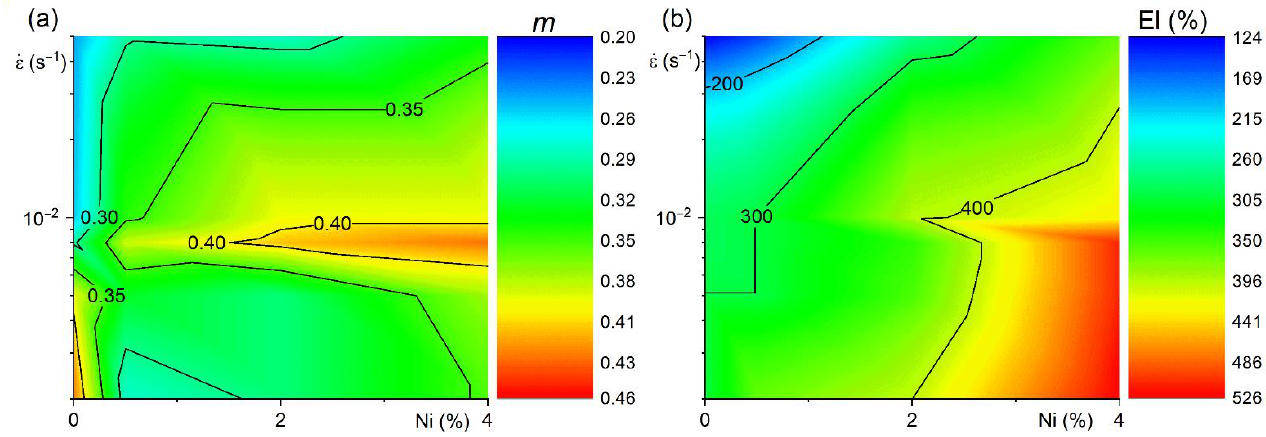
Figure 12. The dependences of ( a ) strain rate sensitivity m -coefficient and ( b ) elongation to failure vs. Ni content (x-axis) and strain rate (y-axis) at 460 °C.